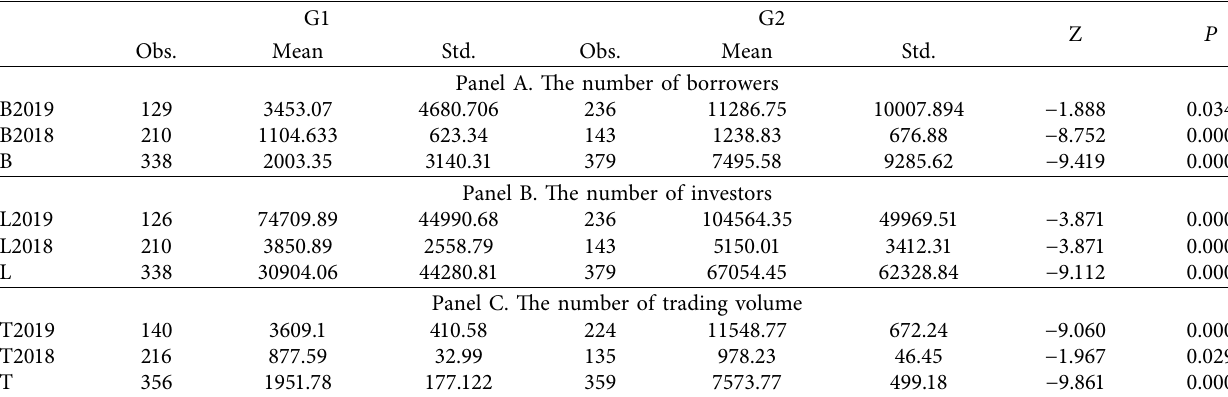
Table 13: Wilcoxon test of the number of